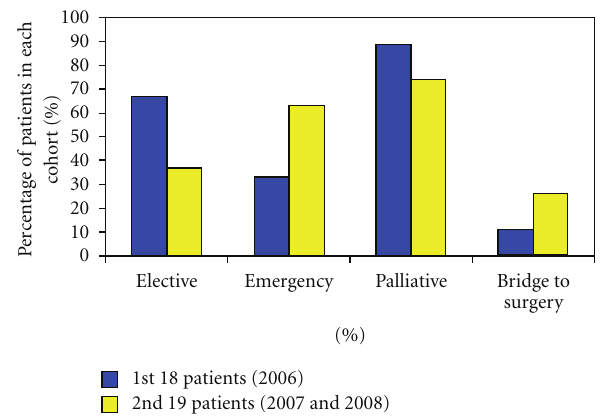
Figure 2: A comparison between the first and second half of the case series showing the change in practice over time. Table 1: The learning curve for SEMS. N ◦ of stents per Percentage success Stenting group (%)